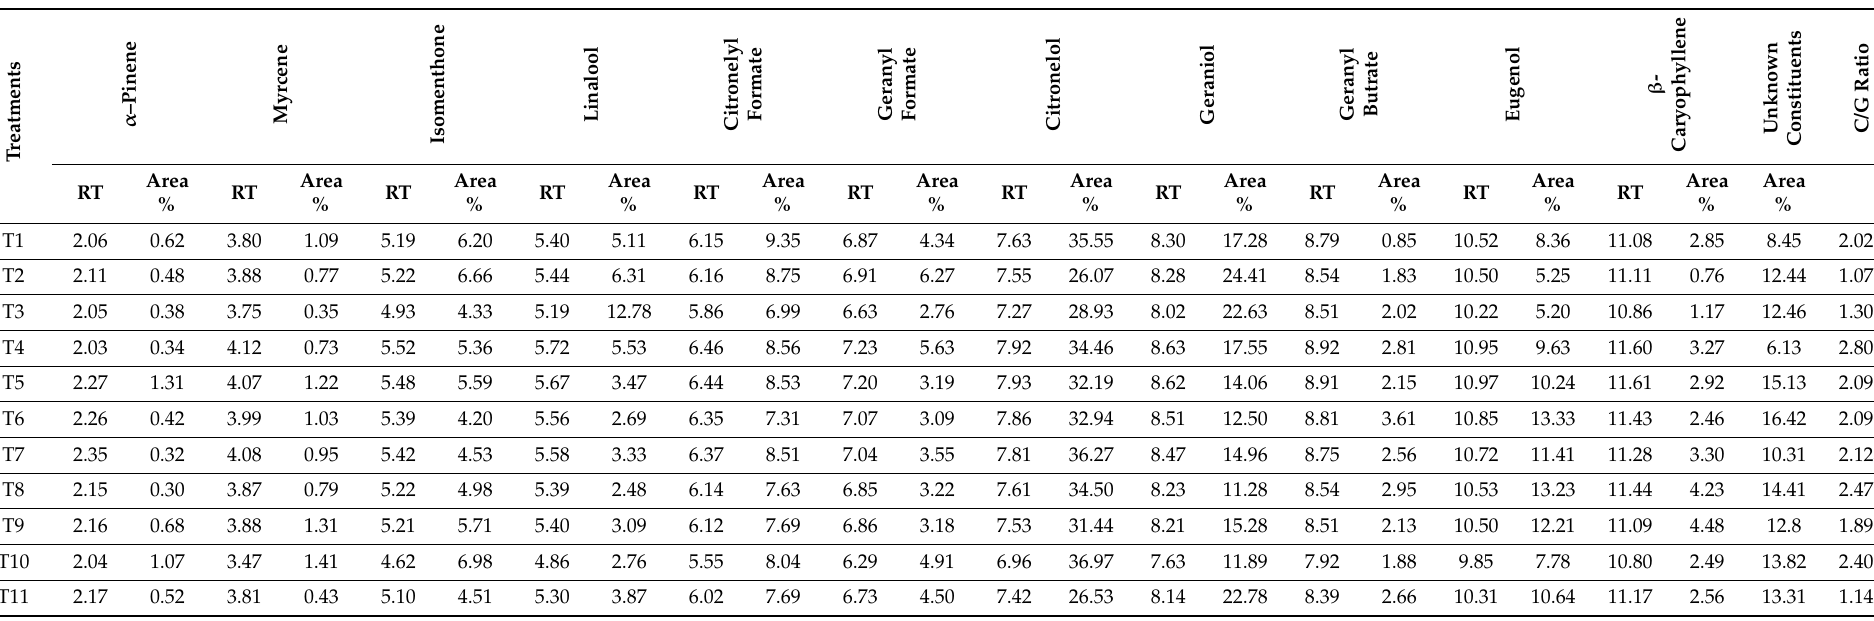
Table 5. Effect of iron (nano, sulfate, and chelated) foliar spray on essential oil active constituent’s retention time (RT) and percentage (area %) of Sweet Scented geranium in the second cut during the 2019 experimental season. Means of three replicates are presented with ±